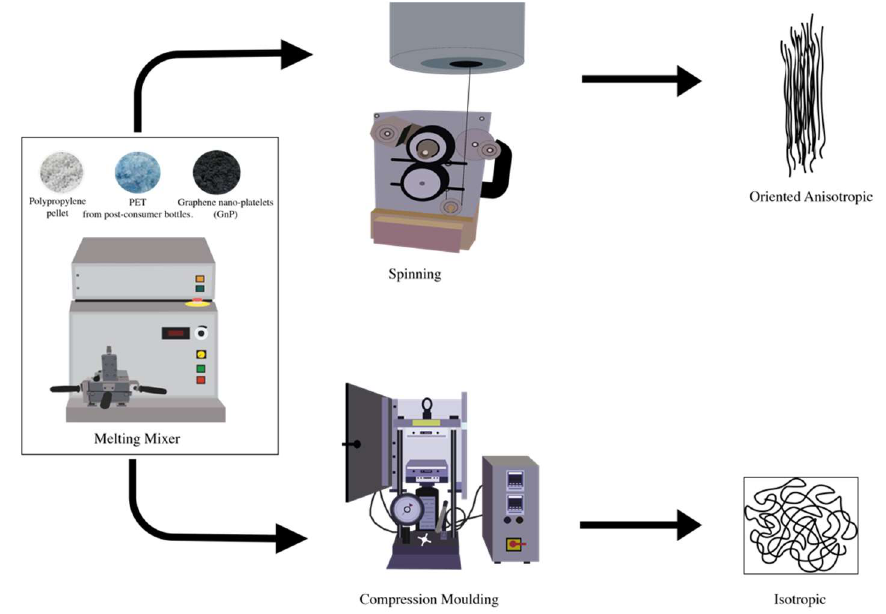
Figure 1. Scheme of the procedure adopted in this work.